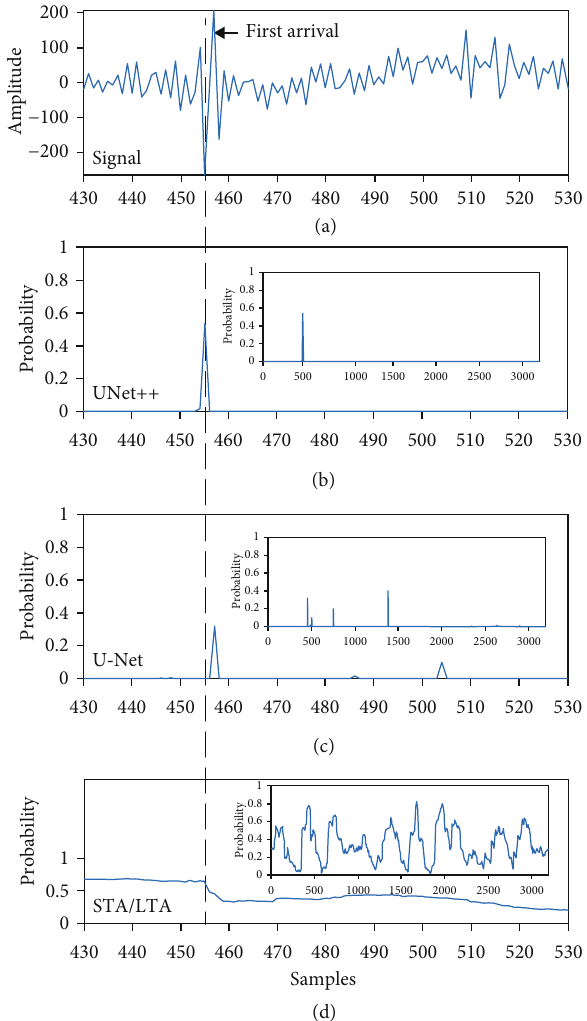
Figure 19: First-arrival picking result of the signal shown in Figure 18(a). (a) Local ampli fi cation of the signal in the range from 3650 ms to 3800 ms. (b) The picking result in the signal band from 3650 ms to 3800 ms obtained by the UNet++. (c) The picking result in the signal band from 3650 ms to 3800 ms obtained by the U-Net. (d) The picking result in the signal band from 3650 ms to 3800 ms obtained by the STA/LTA for the long- and short-time windows of 300 and 100, respectively.